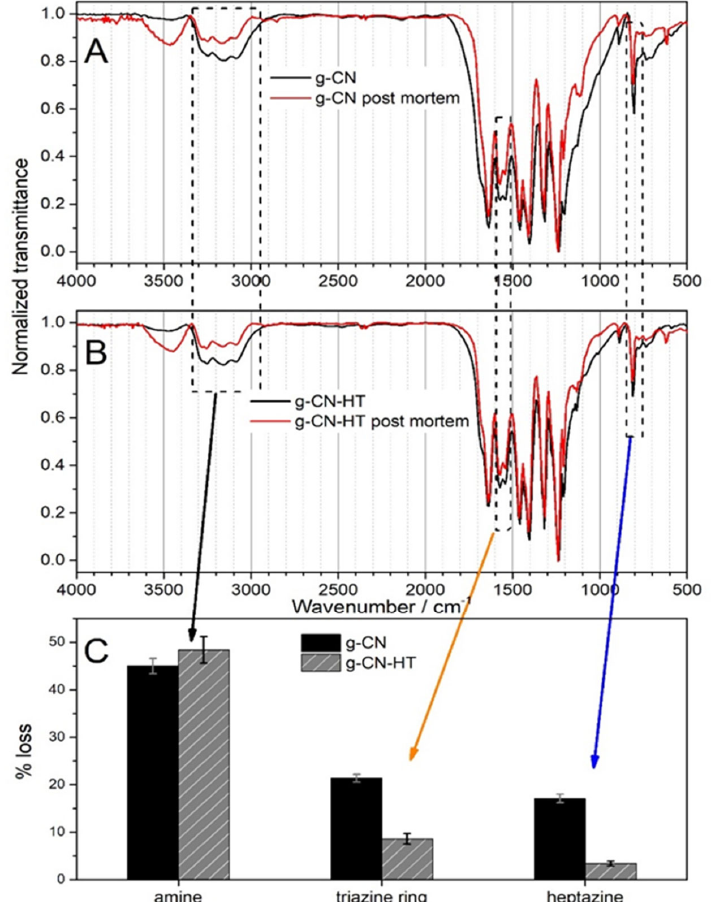
Figure 5. FT-IR investigations of g-CN ( A ) and g-CN-HT ( B ). The percentage losses of amine (black arrow), ring unit (orange arrow) and the triazine unit (blue arrow) are shown in ( C ) and were calculated as the difference in absorbance between the initial and post-mortem samples and divided by the absorbance of the initial sample.